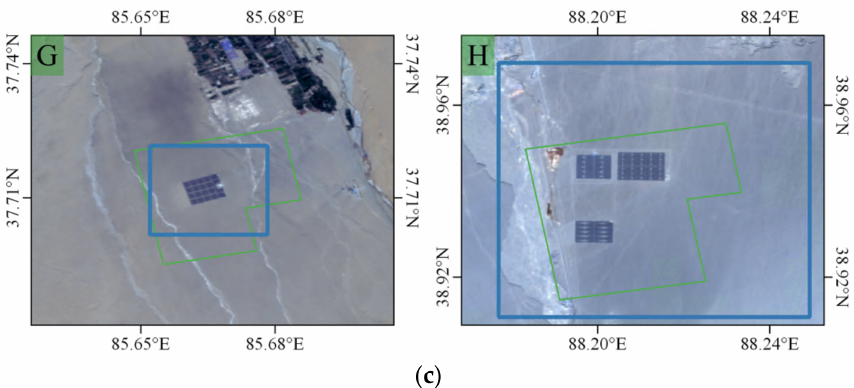
Figure 8. Spatial information positioning results of photovoltaic power plants in the study area. ( a ) Spatial information positioning results of photovoltaic power plants in Qinghai Province. ( b ) Spa- tial information positioning results of photovoltaic power plants in Gansu Province. ( c ) Spatial information positioning results of photovoltaic power plants in Xinjiang Uygur Autonomous